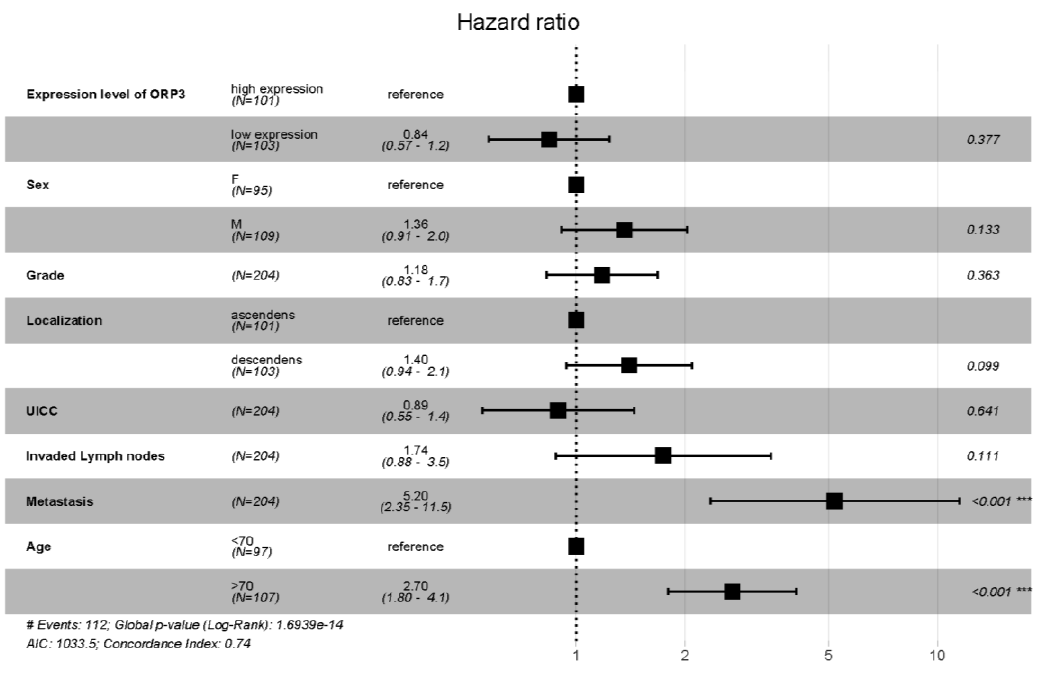
Figure 2. Hazard ratio calculated using a cox proportional-hazards analysis of the combined cohort. Hazard ratios > 1 indicate an increased risk of dying. While hazard ratios < 1 indicate a beneficial outcome for the patient. p -values of each individual factor based on the multivariate analysis is depicted on the right of the figure with the values: *** indicates p < 0.001.